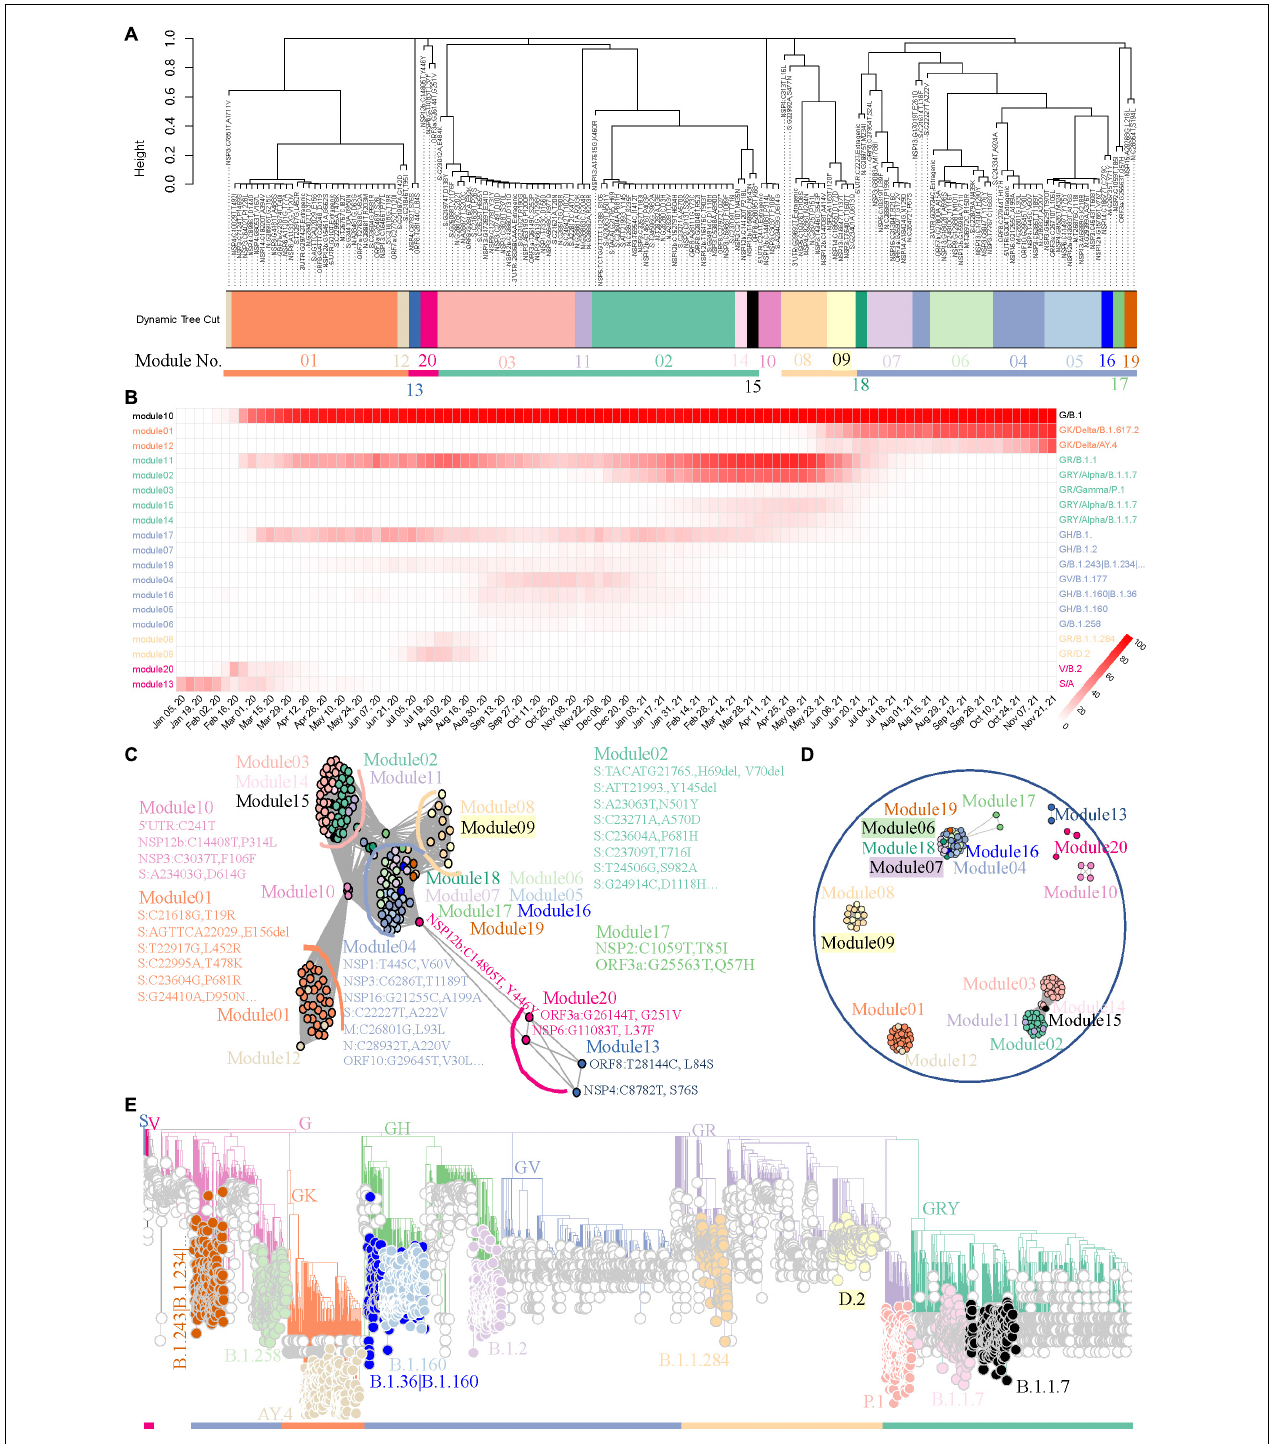
FIGURE 3 | A benchmark to use weighted network framework for identification of worldwide pandemic variants. (A) Clustering dendrogram of 158 FTMs from GISAID worldwide data. The module numbers are labeled and module clusters are highlighted with different colors. (B) The heatmap of module-based variant prevalence. The variants were determined by core mutations within each module. The modules were reordered and colored according to their module clusters and time course. (C) Network graph with topology overlap values > 10 - 3 to show the relationship between nodes and modules of the weighted network. (D) Network graph with topology overlap values > 0.1. (E) Phylogenic evaluation of detected worldwide pandemic variants. Time-resolved maximum clade credibility phylogeny is shown and identified variants are highlighted and annotated with visually friendly colors.